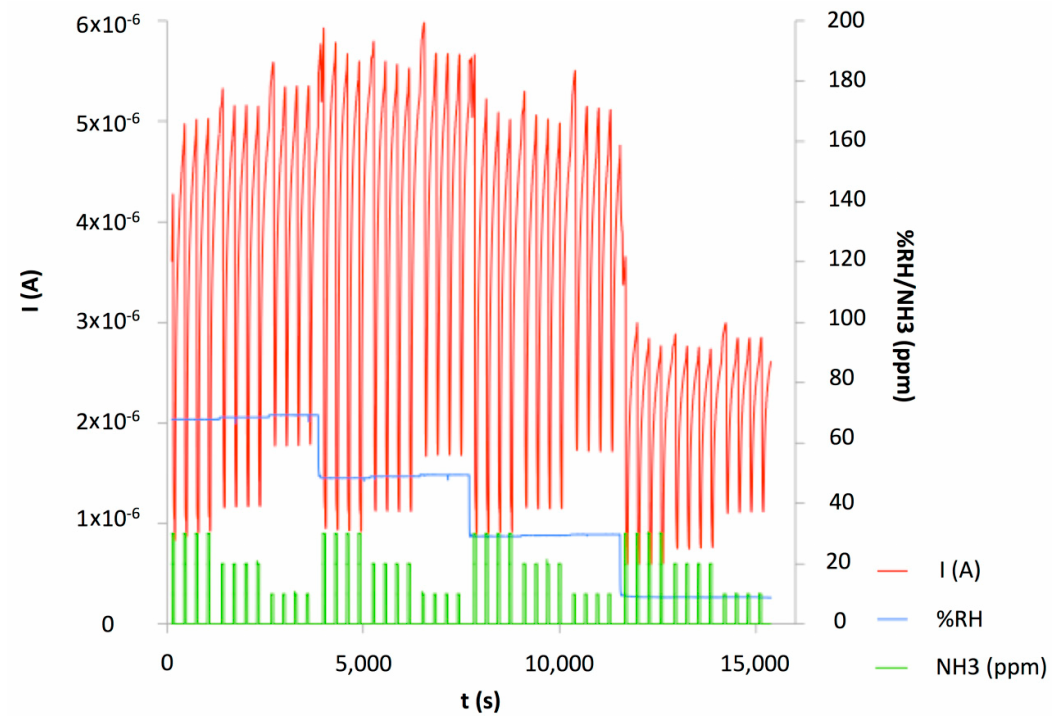
Figure 11. Ammonia/humidity exposure/recovery of a (PANI/CuTsPc) 20 and 10 ppm ammonia, with 70% to 10% RH, polarized at 1